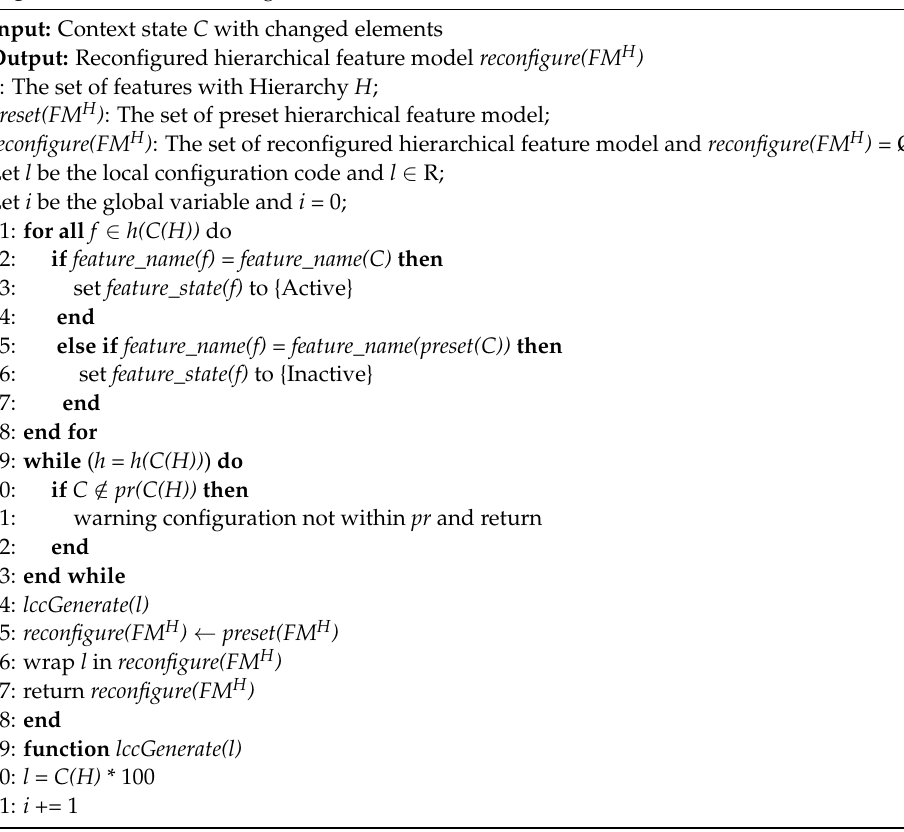
Algorithm 1. Model